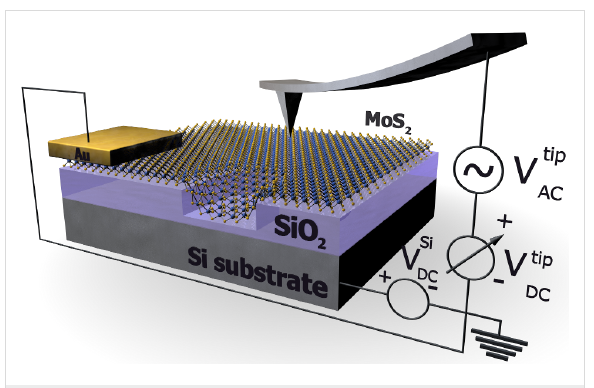
Figure 1: Schematic representation of the KPFM setup and the MoS 2 sample with the RIE SiO 2